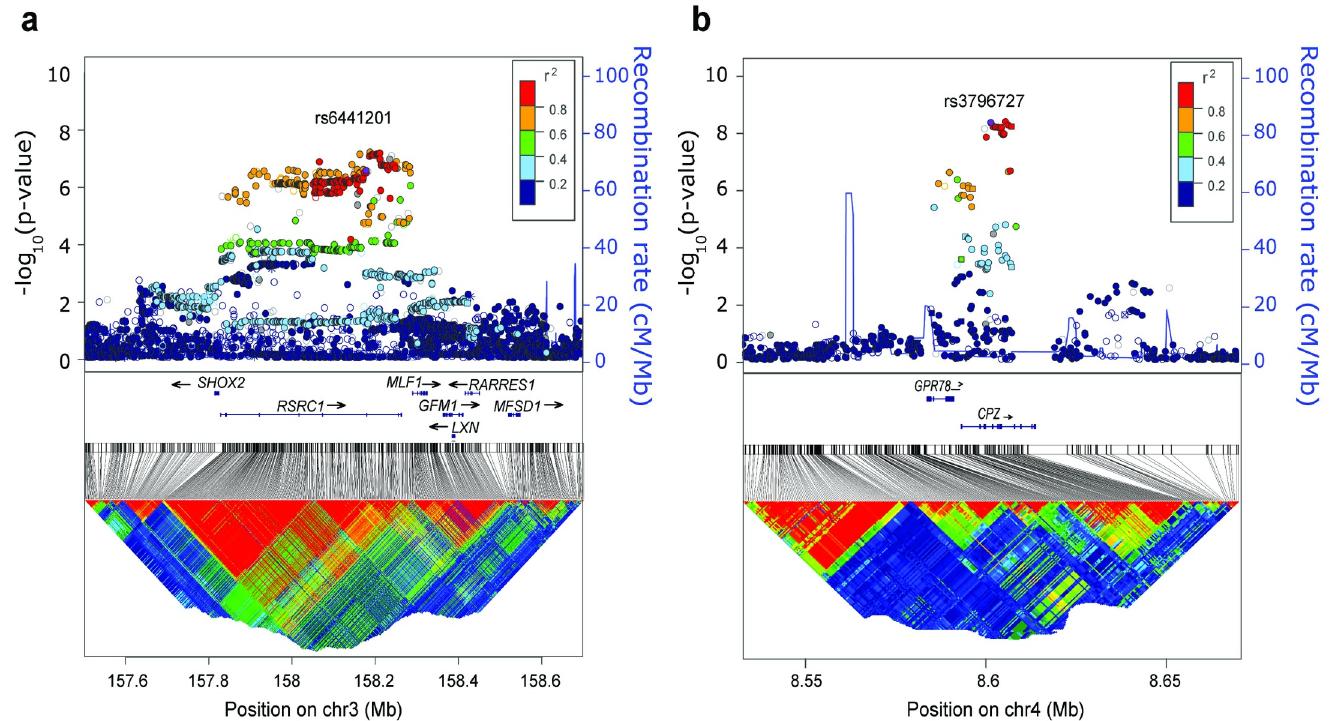
Fig 3. Discoveryof neuroblastoma susceptibility loci at chromosome 3q25 and 4p16. Regionalassociationplots of genotyped and imputedSNPs novel susceptibility loci. Plots were generatedusing LocusZoom.Y-axes represent the significanceof association(-log10transformed P values)and the recombination rate. SNPs are color-codedbasedon pair-wiselinkagedisequilibrium (r 2 ) with indicatedSNPs (a) 3q25 locus: rs6441201shown in purple (3.01 x 10 − 7 ; Odds Ratio: 1.21, 95% C.I.: 1.12–1.30). (b) 4p16 locus: rs3796727shownin purple(p = 5.25 x 10 − 9 ; Odds Ratio: 1.26, 95% C.I.: